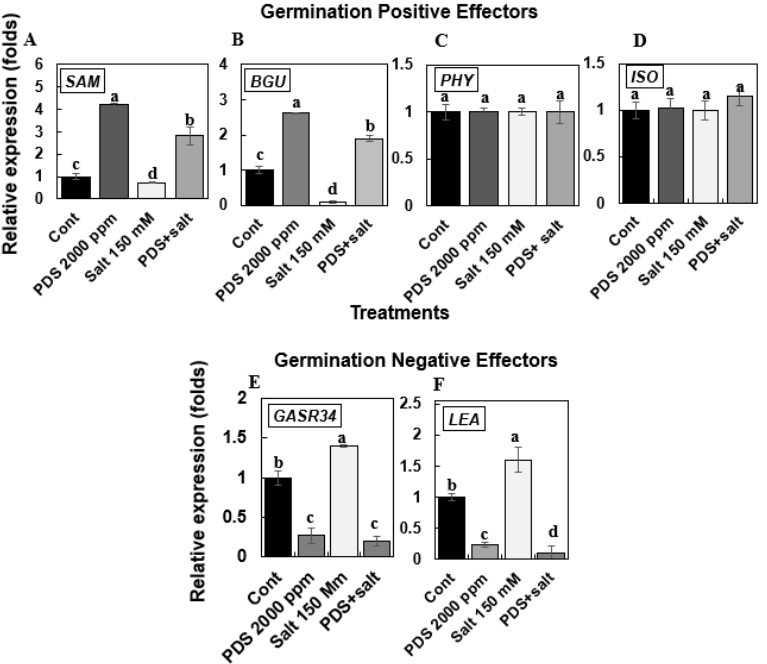
Figure 2. Expression patterns of germination marker genes were analyzed under PDS 2000 ppm and salt (150 and 200 mM). Wheat seeds were germinated in Petri plates supplemented with PDS 2000 ppm. Germinated seeds after 48 h were collected for extraction of total RNA to perform qRT-PCR. ( A – D ) The bars show the fold increase or decrease in the expression levels of germination positive effector genes upon treatment with PDS 2000 ppm, salt stress, salt + PDS. ( E , F ) Graphical bars represent the effect of PDS 2000 ppm, salt stress (150 mM) and salt + PDS 2000 ppm on the expression levels of germination negative marker genes in wheat. The y -axis shows fold change in the expression of genes. The x -axis represents the different treatments. All data were analyzed using one-way ANOVA, with multiple comparisons using LSD test at a significance threshold of p ≤ 0.05. Three independent experiments were performed to obtain mean values and standard error bars for each germination experiment. The different lowercase alphabets represent homogeneous subsets and it’s indicates the statistical significantly according to Fisher LSD at level p <